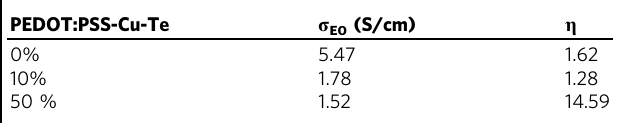
Table 3 Transport parameter and doping values for different Copper